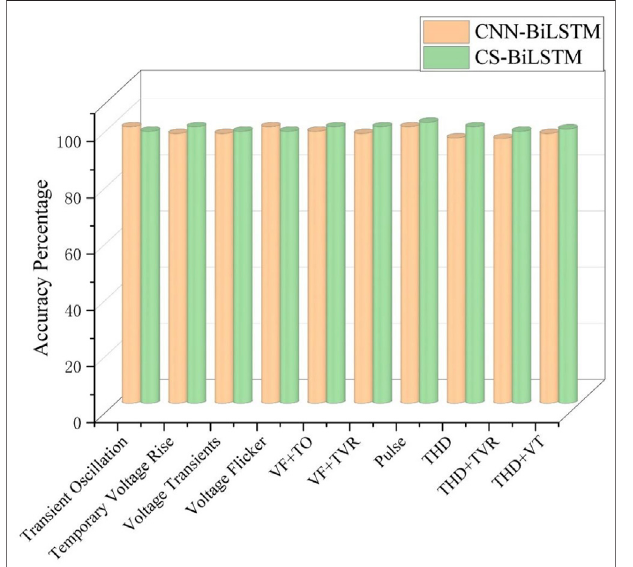
FIGURE 10 | Classi fi cation results of non-noise power quality disturbance signals.